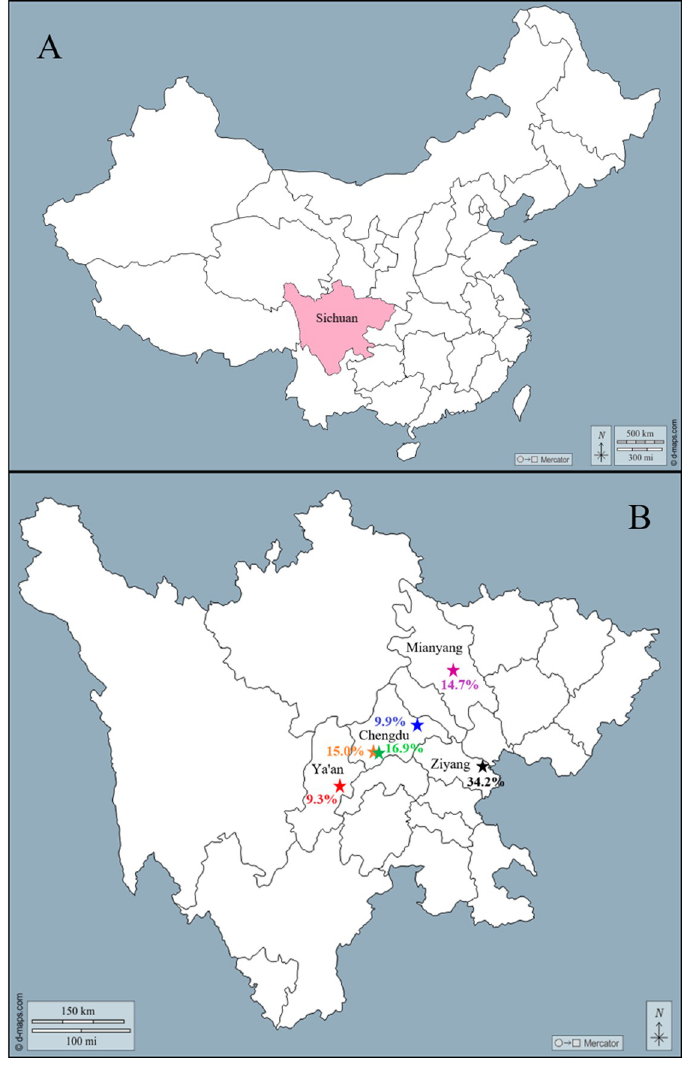
Fig 1. Geographical location of sampling. A, map of China, the colored plate represents Sichuan Province; B, map of Sichuan Province, red star represents Hongya farm, orange star represents Yangba farm, green star represents Yushu farm, blue star represents Qingbaijiang farm, purple star represents Songya farm, and black star represents Ninggang farm, percentages identical to the symbol color indicate the sample collection rate in that dairy farm. All original maps were download from